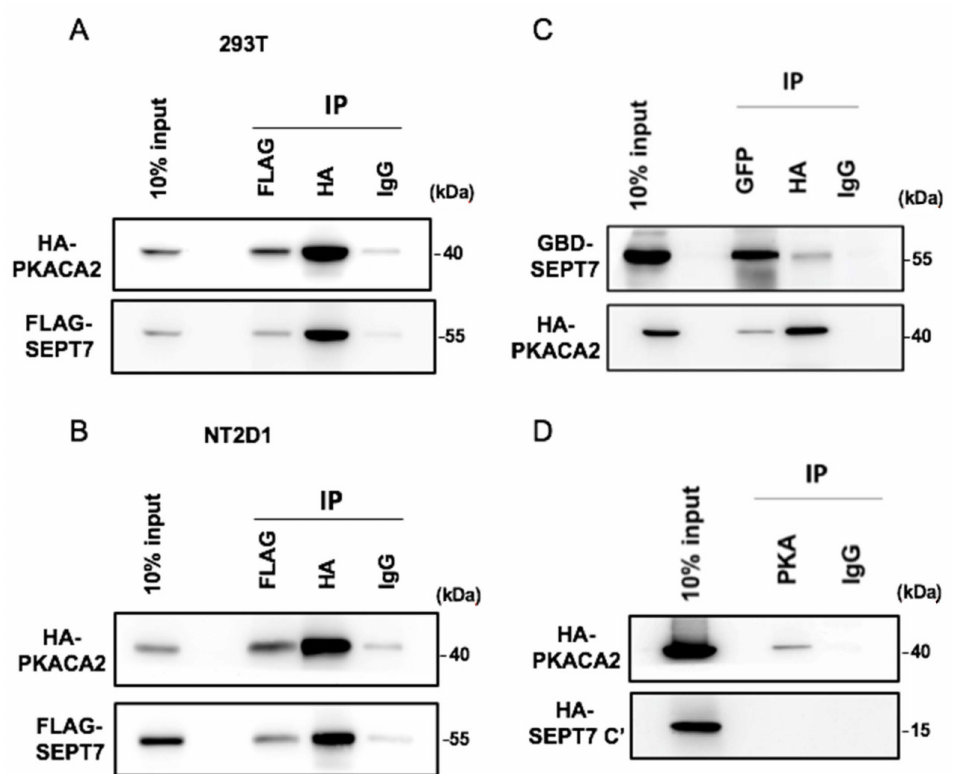
Figure 3. SEPT7 interacts with PKA via the GTP-binding domain. SEPT7 interacted with PKA ( A , B ) via its GTP-binding domain, not its C-terminus (C’) domain ( C ). FLAG-SEPT7 and HA-PKACA2 were co-transfected to 293T cells or NT2/D1 cells followed by an immunoprecipitation assay. ( A , B ) PKACA2 was detected in the precipitant of FLAG-SEPT7 and vice versa. Extracts of FLAG-SEPT7 and HA-PKACA2 co-transfected 293T or NT2/D1 cells were immunoprecipitated by FLAG or HA with antibodies against HA and FLAG. Transfected IgG served as a negative control. Lanes showing 10% of the input are also present. ( C ) GFP-tagged GBD of SEPT7 (GFP-GBD-SEPT7) and HA-PKACA2 were co-transfected to NT2/D1 cells, followed by an immunoprecipitation assay. Extracts of GFP- GBD-SEPT7 and HA-PKACA2 co-transfected NT2/D1 cells were immunoprecipitated by GFP or HA with antibodies against HA and GFP. ( D ) Co-transfected HA-SEPT7-C terminal and HA-PKACA2 in NT2/D1 cells, followed by the performance of an immunoprecipitation assay. Extracts of HA- SEPT7 C’ and HA-PKACA2 co-transfected NT2/D1 cells were immunoprecipitated by PKA with an antibody against PKA. Transfected IgG served as a negative control. Lanes showing 10% of the input are also